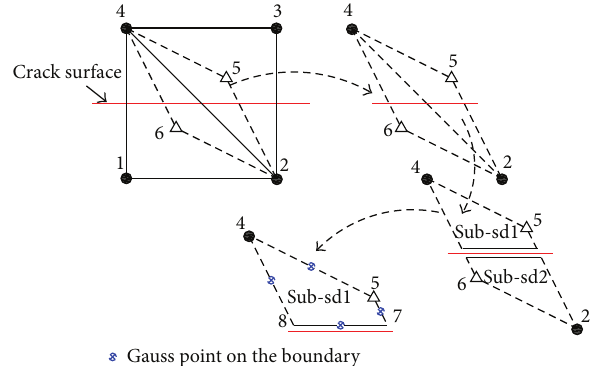
Figure 6: The decomposition of a completely cracked smoothing domain into two superimposed smoothing domains.